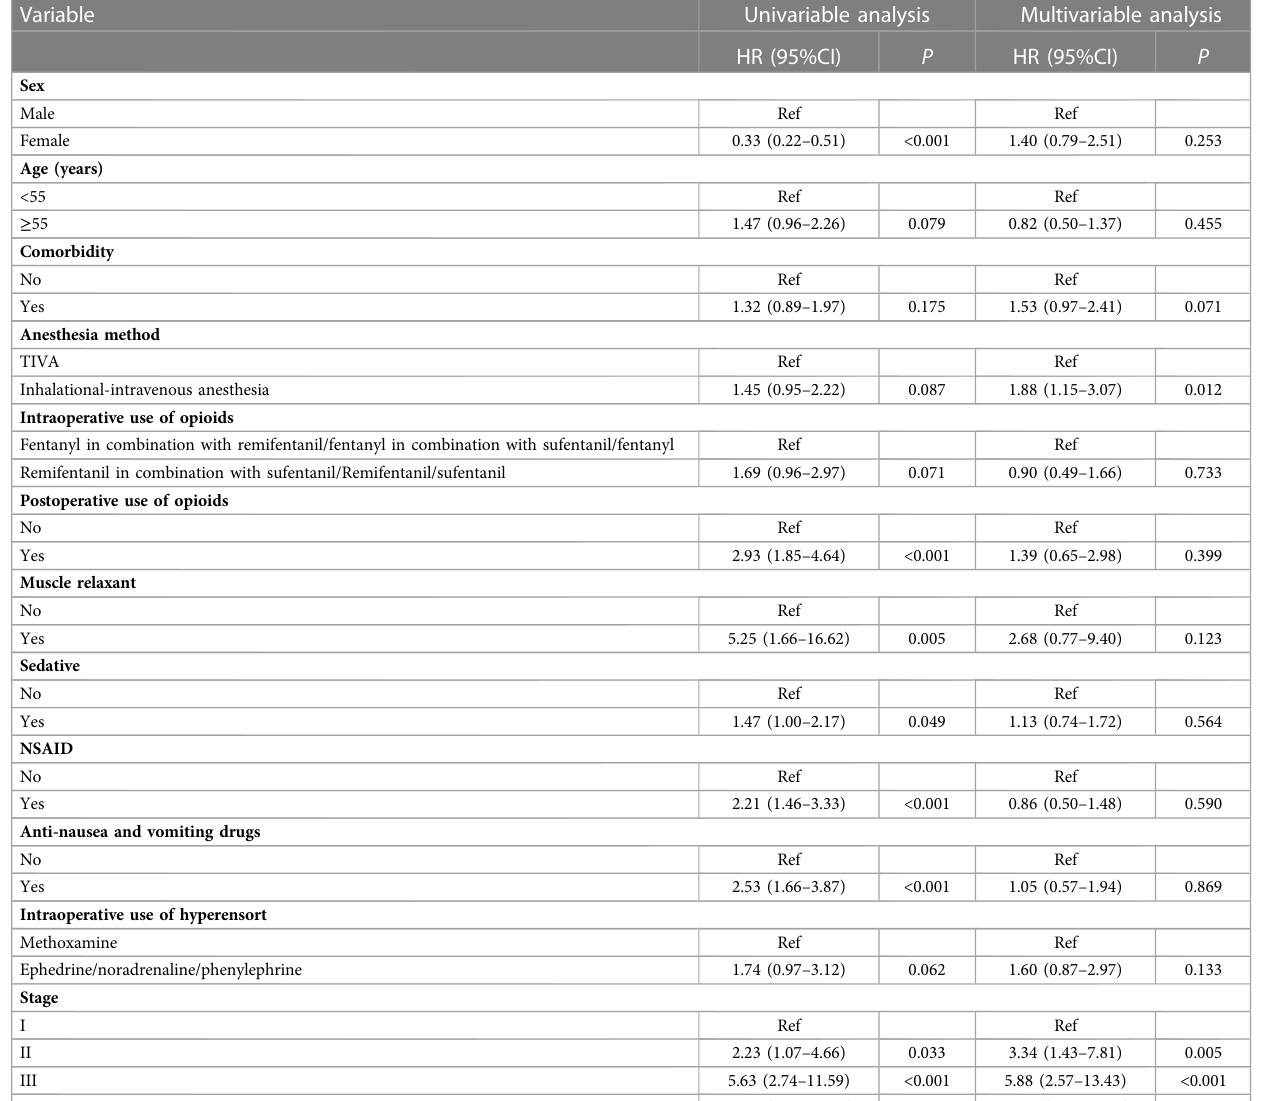
TABLE 2 In fl uencing factors of recurrence/metastasis of